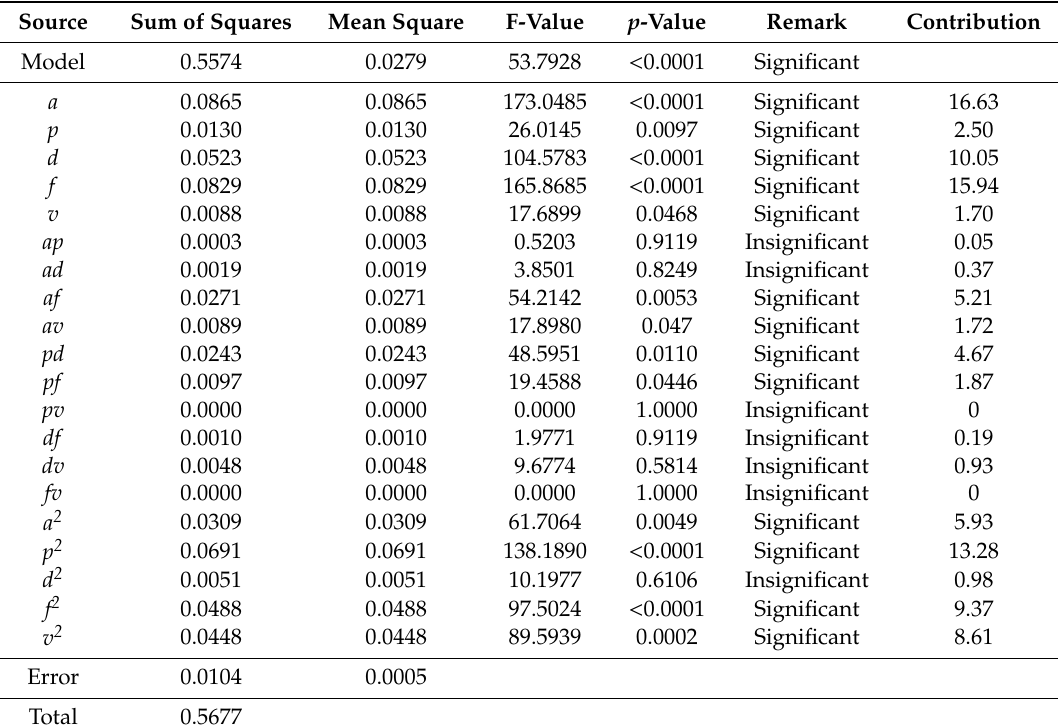
Table 4. ANOVA results for decreased roughness rate.